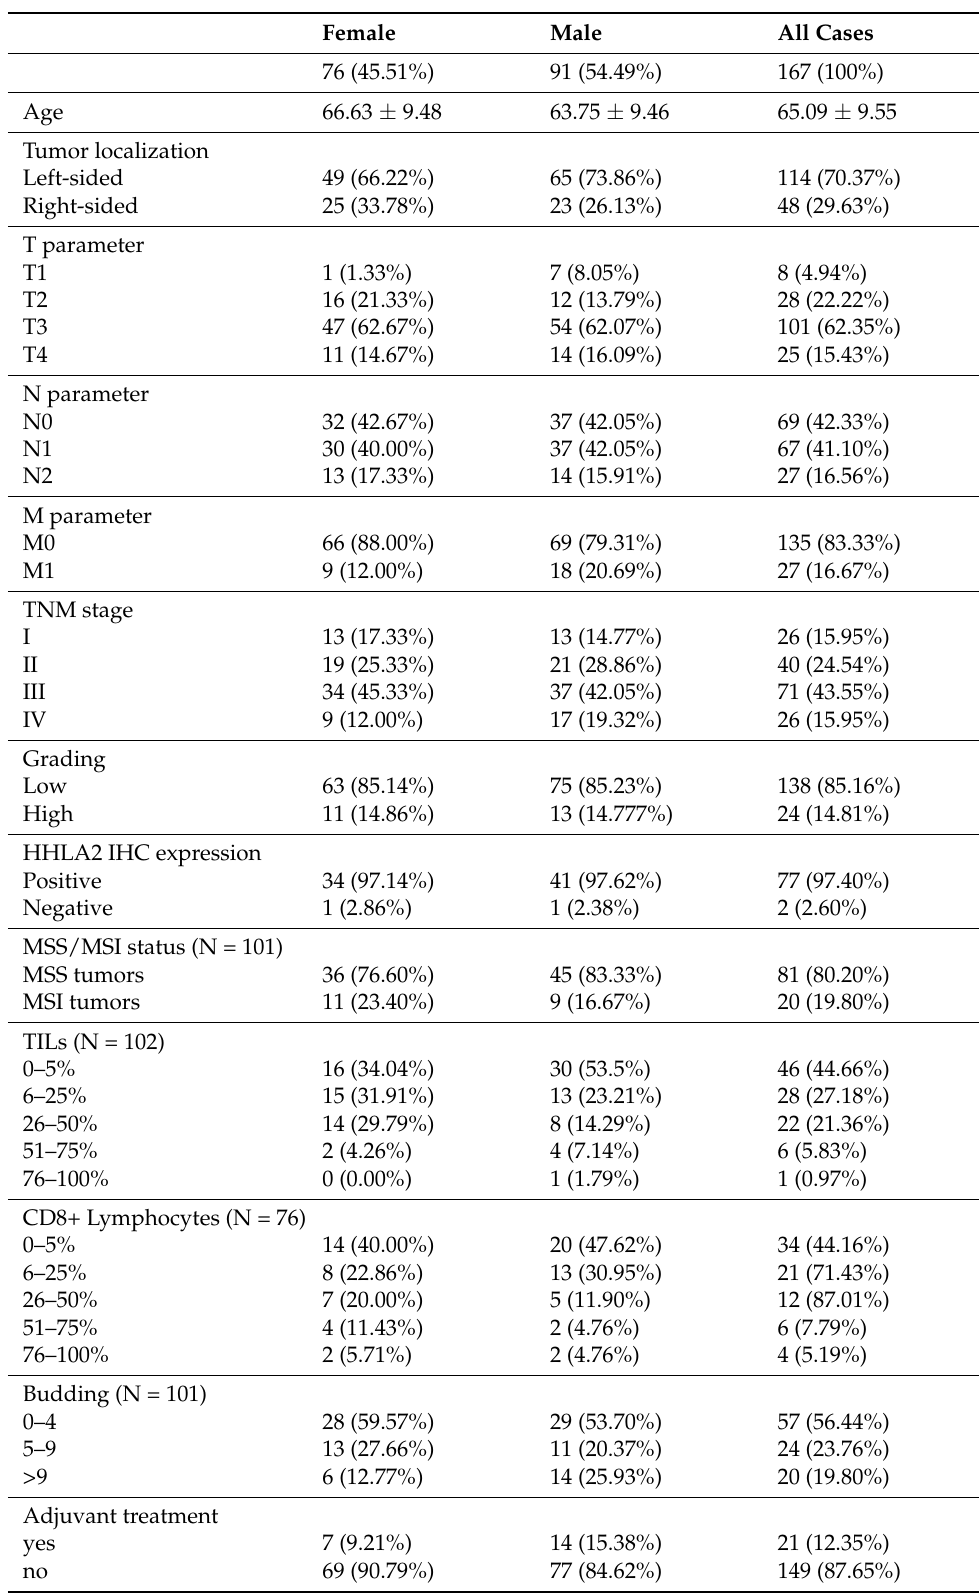
Table 6. Patients